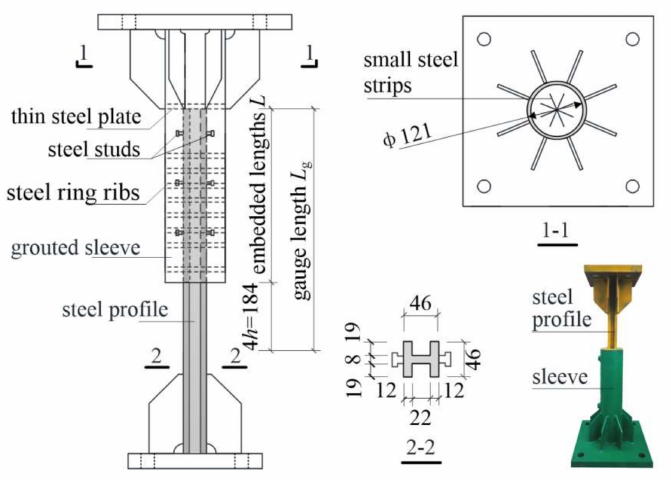
Figure 3. Geometry and configuration of